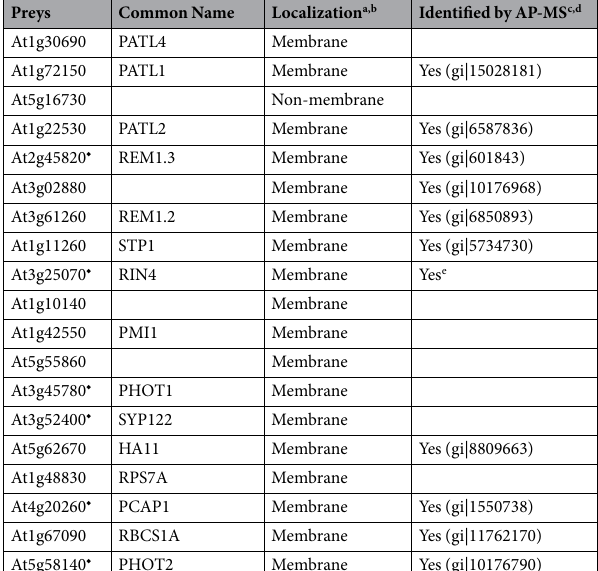
Table 1. Significant Preys identified in HopF2-BirA * but not in BirA * . a Membrane or non-membrane based on subcellular localization information on Uniprot.org. b 94.74% of HopF2-BirA * -specific preys are membrane localized. c Identified in the AP-MS data of Hurley et al . 18 , in at least one HopF2 replicate and not in the negative control 18 . d 57.89% of HopF2-BirA * -specific preys were also identified by AP-MS 18 . e Detected by western blotting 14,18 . ◆ Proteins previously identified as being involved in plant immunity 21,24–27